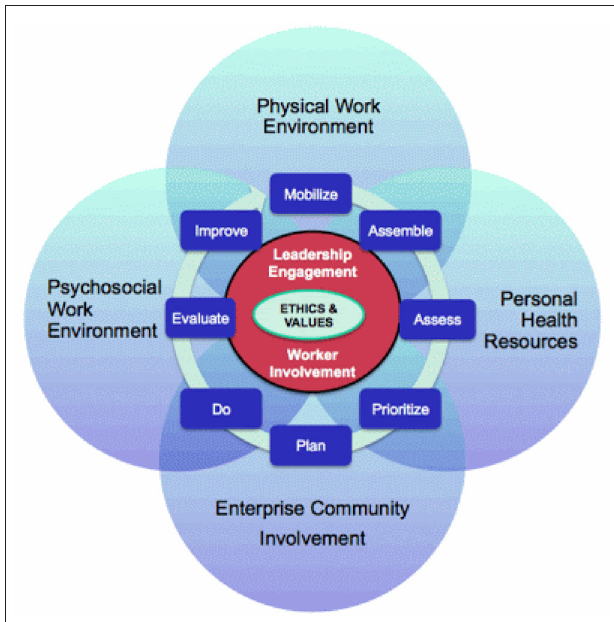
FIGURE 1 | WHO Healthy Workplace Model. Source: Burton and WHO